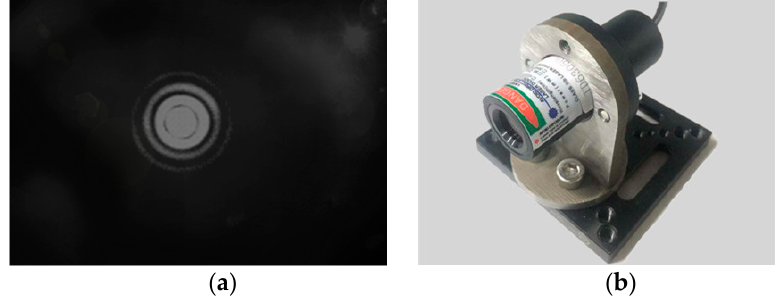
Figure 25. ( a ) laser spot image in 70 m receiving distance; ( b ) high power laser with optical lens.